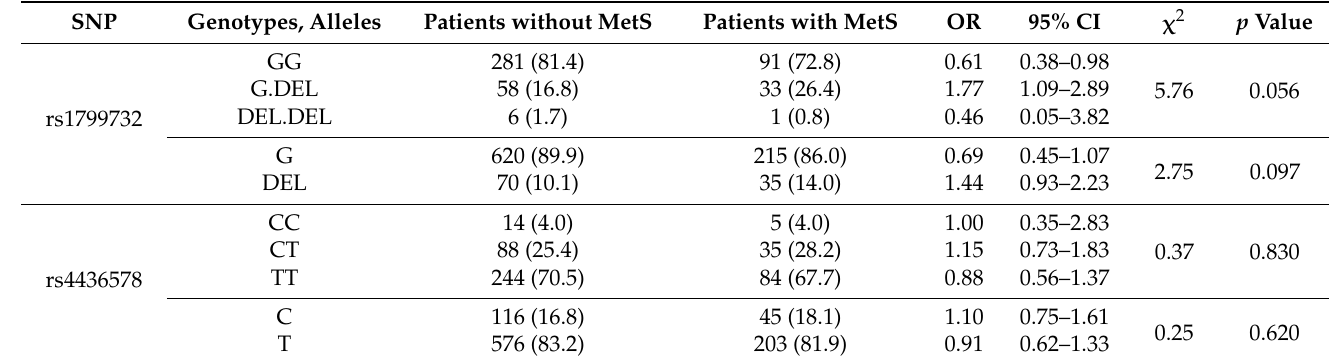
Table 3. Distribution of alleles and genotypes of DRD2 polymorphisms in groups of patients without and with MetS.